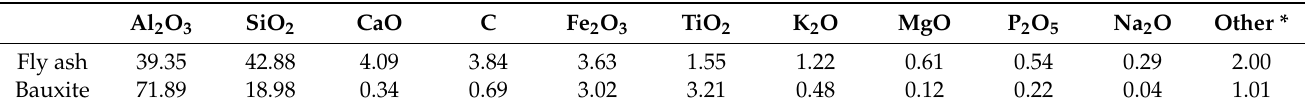
Table 2. Compositions of fly ash and bauxite (wt%). * Other represents the sum of other oxides with lower content, including SrO, ZrO 2 , CeO 2 , MnO, and V 2 O 5 . Al 2 O 3 Fly